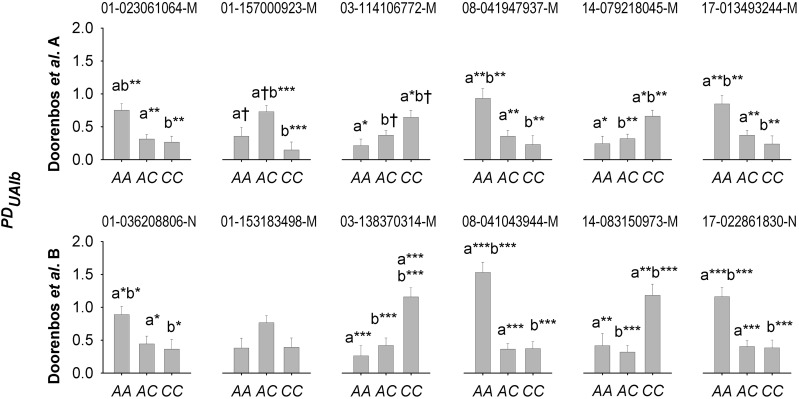
Differences in mean genotypic effects on phenotypic dispersion in urinary albumin (PDUAlb) by single nucleotide polymorphism (SNP) genotype for genomic regions syntenically associated with PDUAlb in 383 male F2 C57BL/6J × A/J mice (‘Doorenbos et al. A’) and 207 male F2 C57BL/6J ApoE−/− × A/J mice (‘Doorenbos et al. B’) {Doorenbos, 2008 #25451} (syntenic regions by figure column). SNP marker names are indicated above each graph with the first two digits being chromosomal designation. Significant differences among genotypes for mean PD are indicated as PBon < 0.10†, < 0.05*, < 0.01**, < 0.001***.